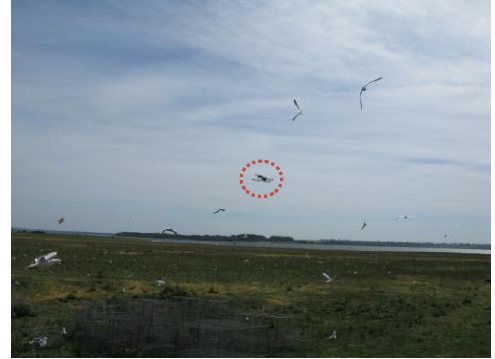
Figure 1. Birds show no disturbance by UAS (Falcon 8)